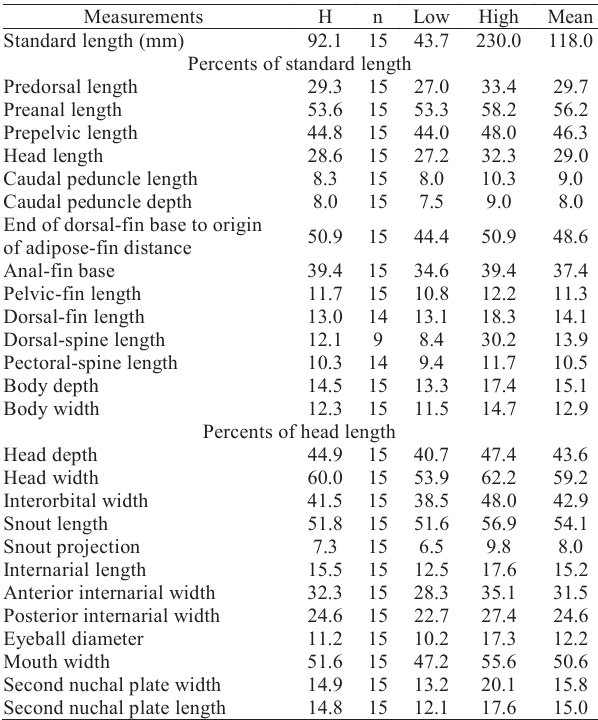
Table 1. Morphometric data of Ageneiosus uranophthalmus . Range includes the holotype